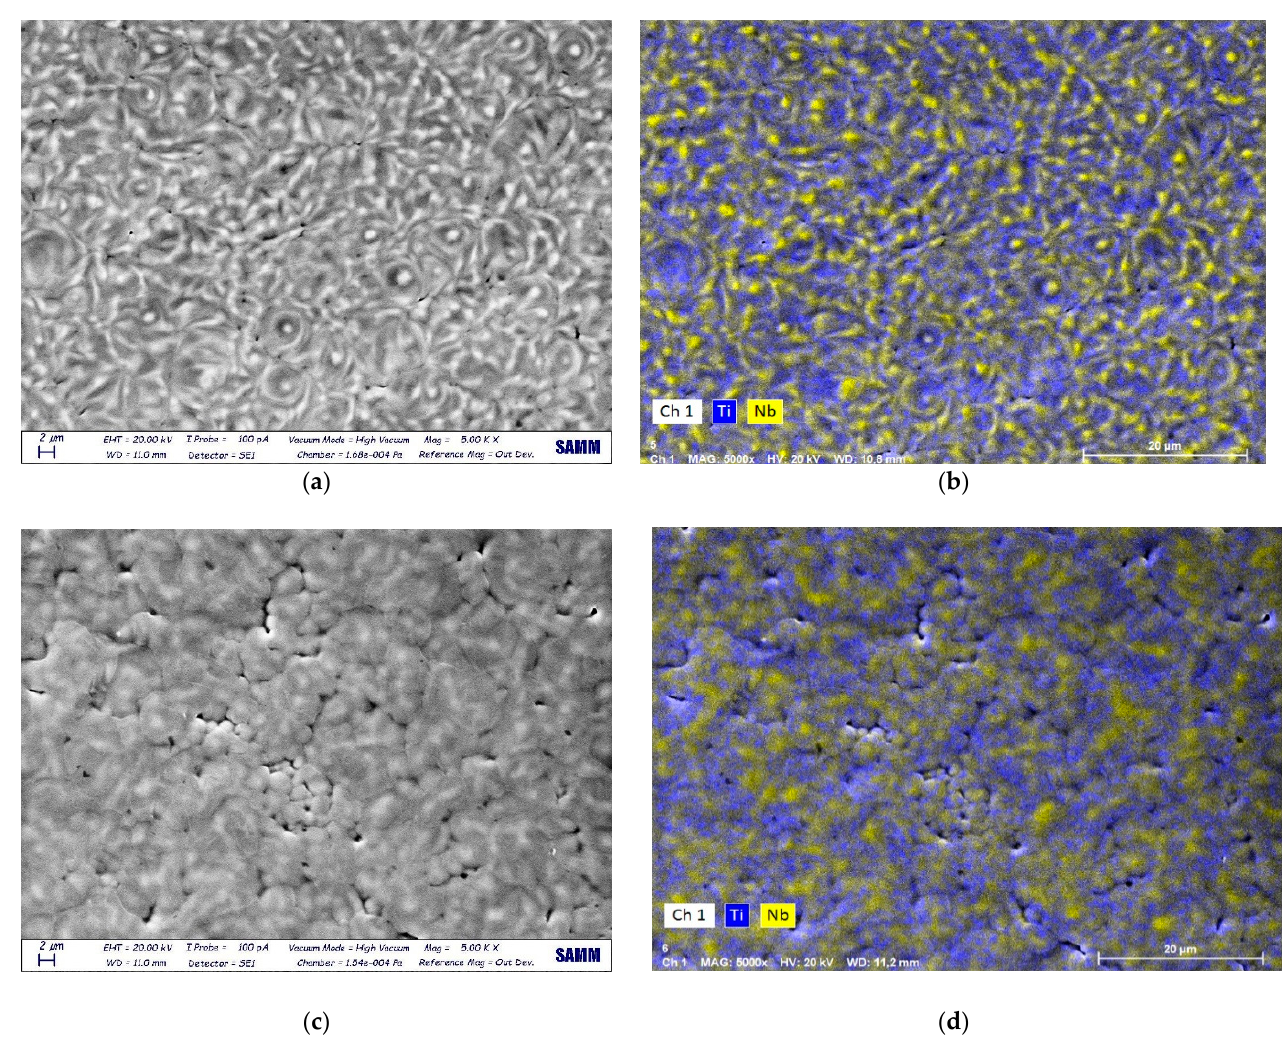
Figure 4. SEM images and EDS maps (Ti, Nb) of sample 5 ( a , b ) and sample 6 ( c , d ), respectively.